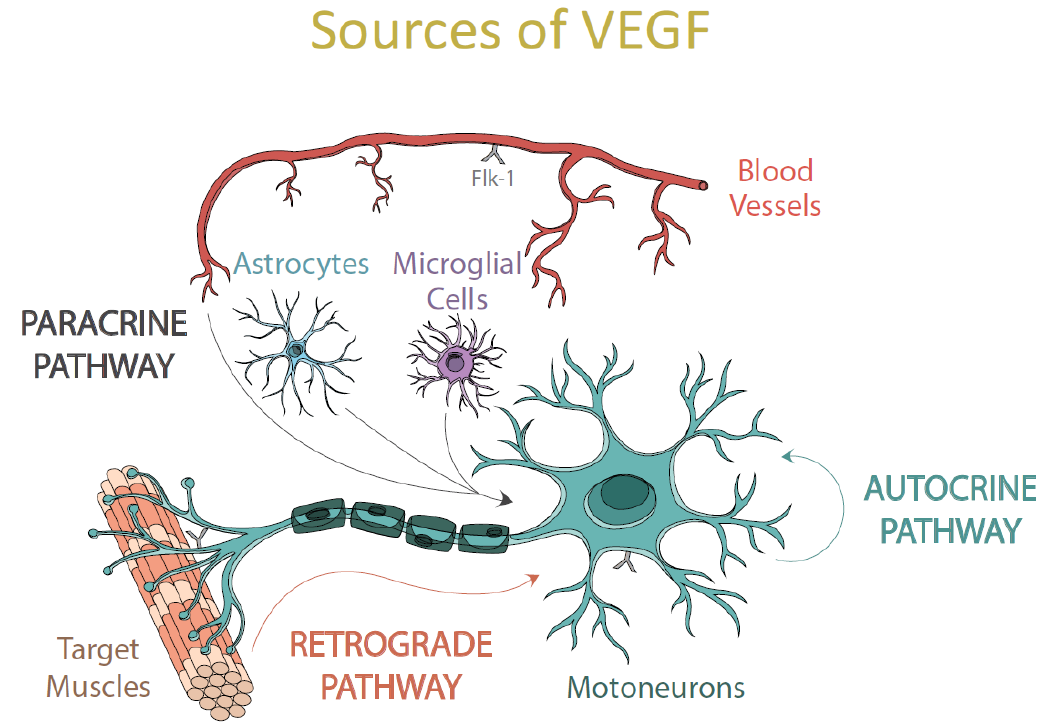
Figure 2. In this scheme, the different pathways of VEGF supply for motoneurons are illustrated. (i) autocrine: self- production of VEGF by the motoneurons themselves; (ii) paracrine: VEGF arriving at the motoneurons from the surrounding cells and blood vessels; and (iii) retrograde: VEGF can also reach the soma of motoneurons from their target muscles.